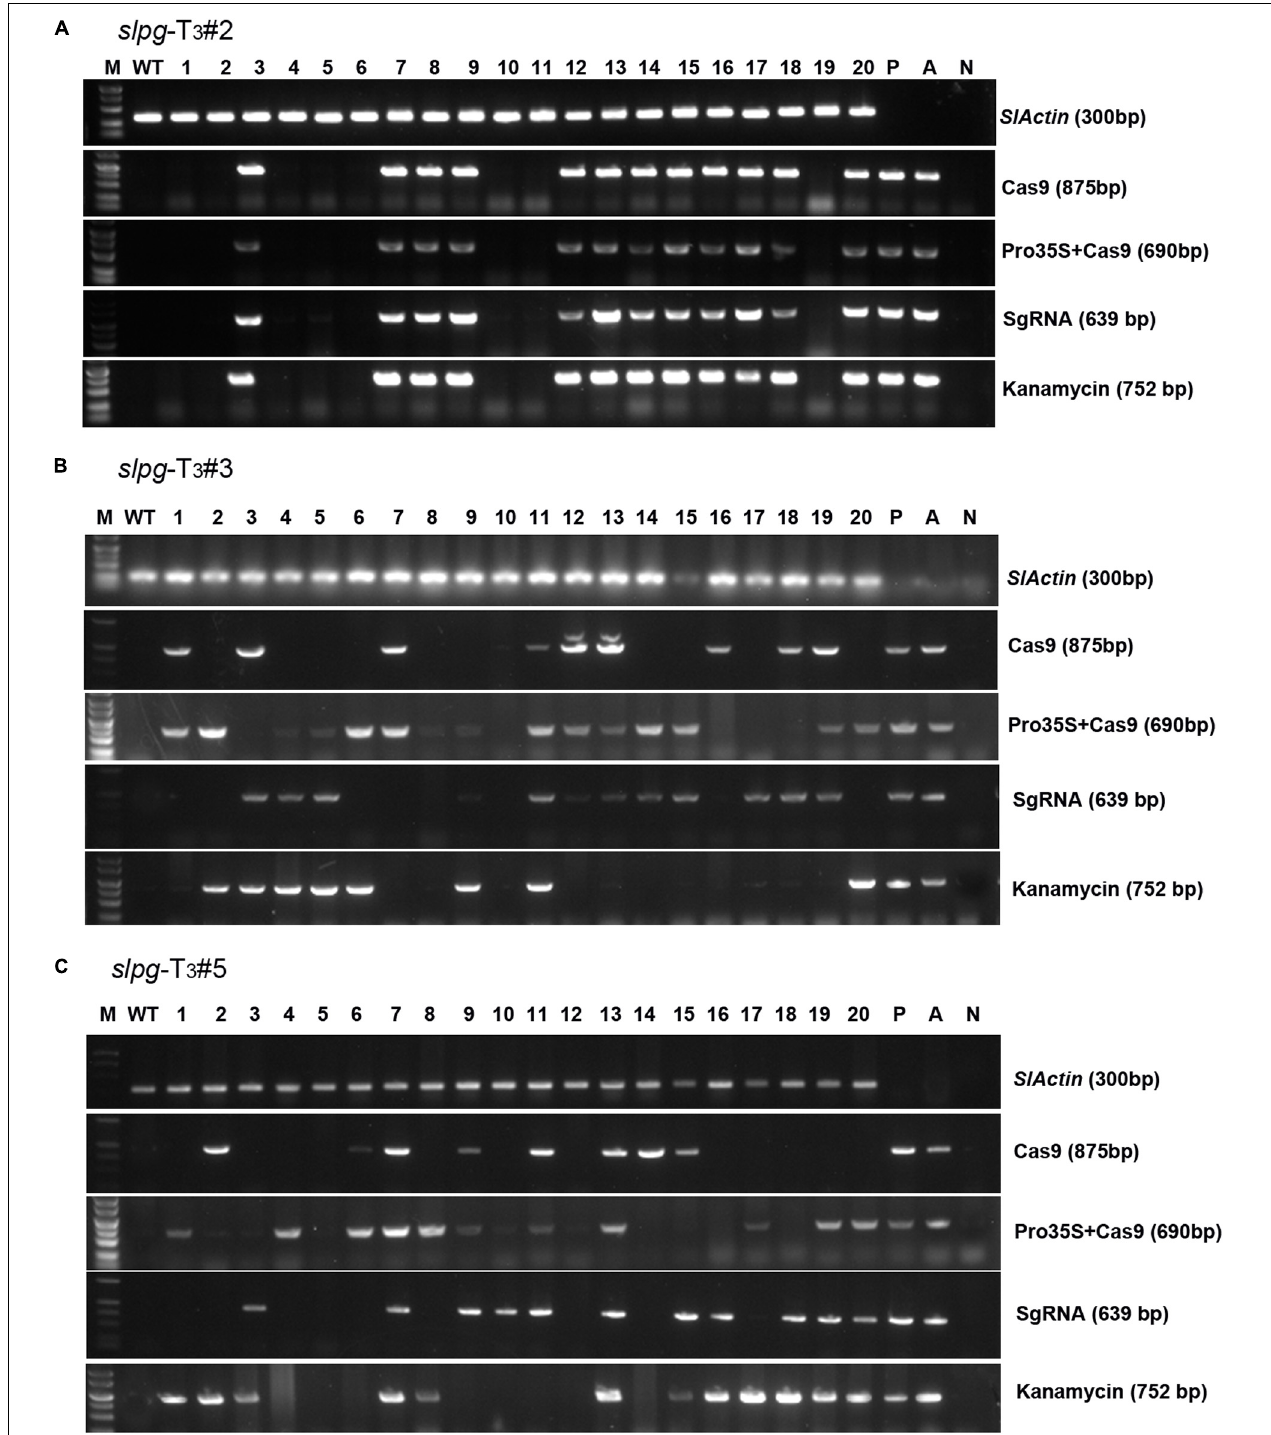
FIGURE 4 | Identifying transgene-free homozygous slpg mutants [ (A) slpg -T 3 #2, (B) slpg -T 3 #3, and (C) slpg -T 3 #5]. Gel image of PCR products obtained with primer sets for four T-DNA regions of sgRNA/Cas9 vector. SlActin (300 bp), part of the tomato Actin coding sequence, was used as a normalization control; Cas9 (875 bp), part of the Cas9 coding sequence; Pro35S + Cas9 (690 bp), region from the downstream of the 35S promoter to the upstream of the Cas9 coding sequence; SgRNA (639 bp), region from the AtU6 promoter to the downstream vector sequence spanning the sgRNA; Kanamycin (752 bp), part of the nptII coding sequence; M, DL5000 ladder DNA marker; WT, DNA of WT plant as a template; Lane 1-20, individual mutant lines; P, positive control (sgRNA/Cas9 vector plasmid as template); A, positive control ( Agrobacterium containing sgRNA/Cas9 vector as template); N, negative control (water as template).